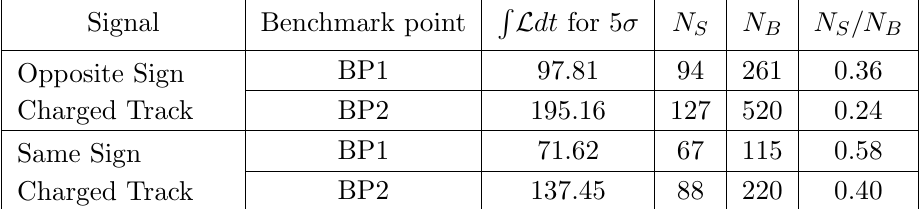
Table 5 . Integrated luminosity (fb (cid:0) 1 ) required to attain 5 (cid:27) statistical signi(cid:12)cance for H (cid:6) H (cid:7) signal for the considered benchmark points during 14 TeV run of